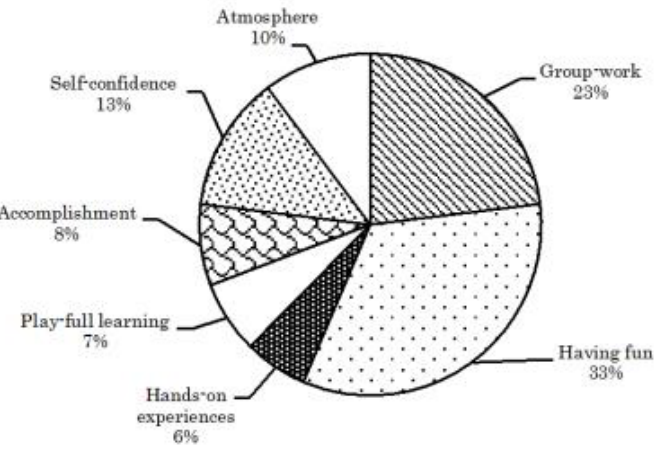
Figure 15 Motivating factors through students' answers in the